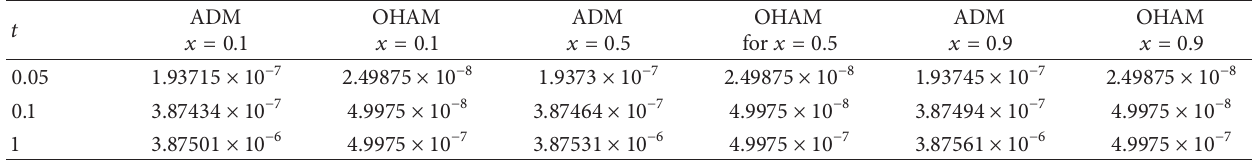
Table 2: Comparison of absolute errors obtained by OHAM and ADM [5] for 𝛼 = 0 , 𝛽 = 1 , 𝛿 = 1 , and 𝛾 = 0.001 . OHAM ADM 𝑡 ADM 𝑥 = 0.1 𝑥 = 0.1 𝑥 = 0.5